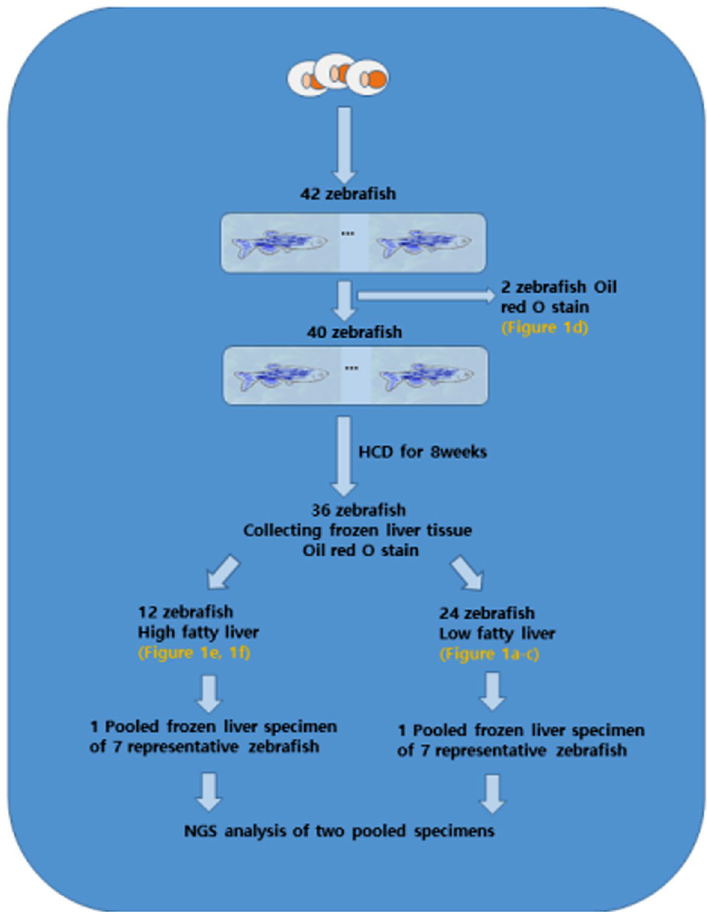
Figure 1. Workflow diagram of the feeding and tissue processing of